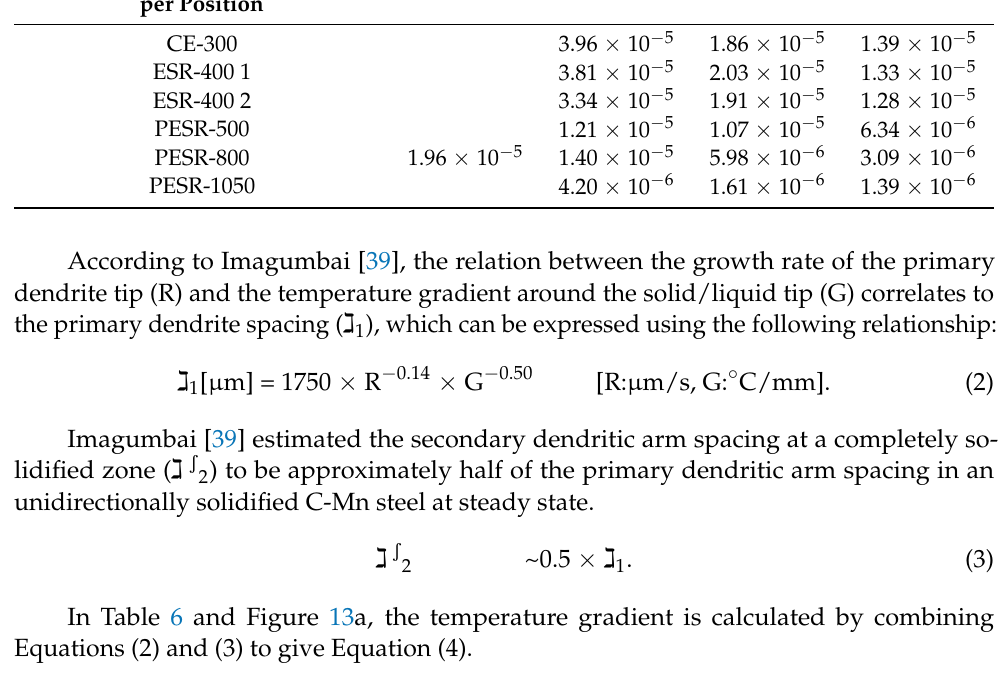
Table 5. Distance from ingot surface (mm) and growth rate, ʋ growth (m/s), per electrode 300 × 300 Distance from ingot surface (mm) and growth rate, Figure 14. Growth rate Ʋ growth (m/s) (calculated on primary dendrite arm spacings) versus the temperature gradient G (°C/m) around the solid/liquid tip. The black line is plotted data from Kurz solidification diagram [40]. The area above the line solidifies in an equiaxial manner and the area below solidifies in a columnar-dendritic manner [40]. Data from Ud- deholms martensitic stainless steel are included, the electrode 300 × 300 mm 2 , (CE-300), the electro-slag remelted ingots 400 × 400 mm 2 , (ESR-400), and the pressure electro-slag remelted ingots 500–1050 mm in diameter, (PESR-500, PESR-800, and PESR-1050). All data are from the center position of the ingots. The electrode and the PESR-1050, which solidify equi- axial dendritic in the center, are marked (●), because the equations used are not valid for the equiaxial solidification struc- ture.